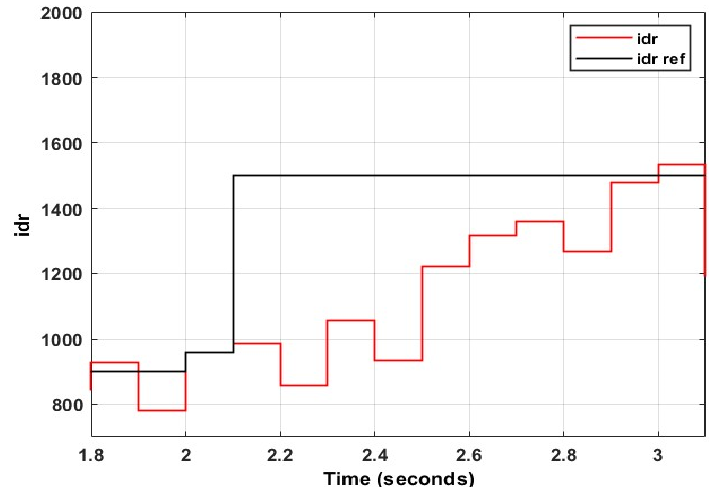
Figure 44. Rotor direct axis current average using LQR at 80% dip.